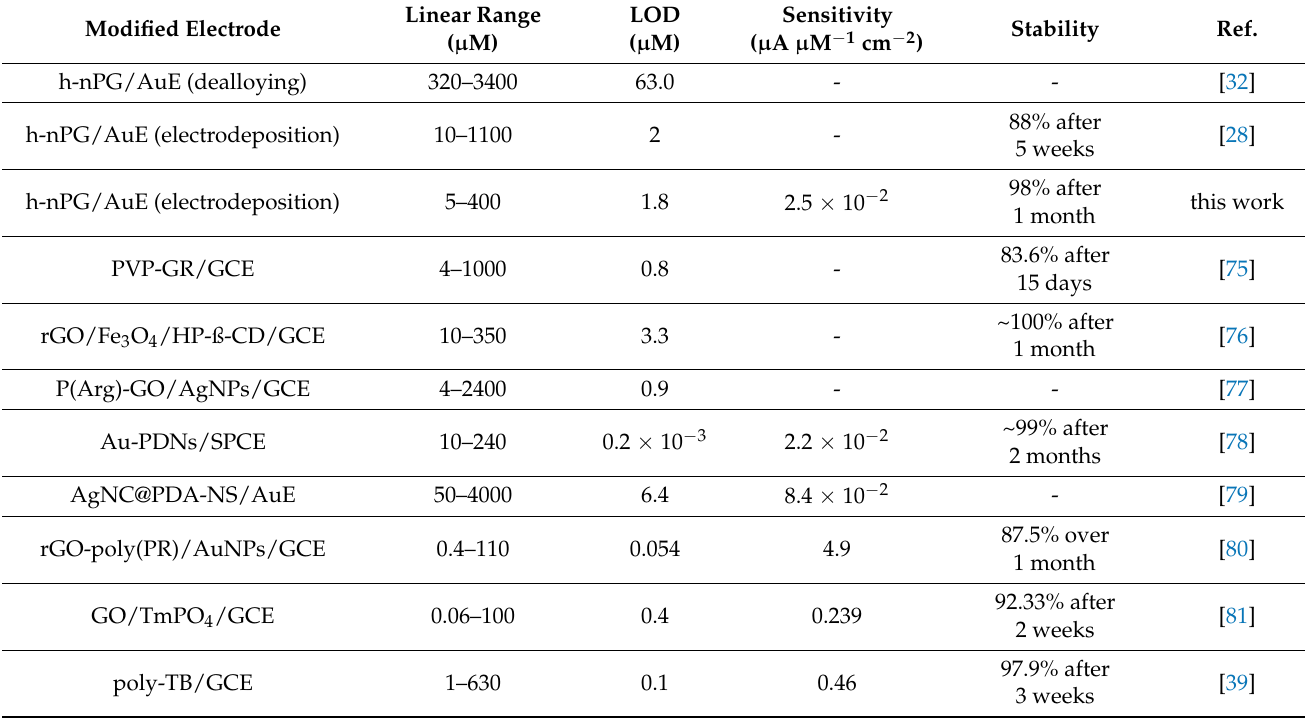
Table 3. Comparison of the analytical performances of recently developed AA